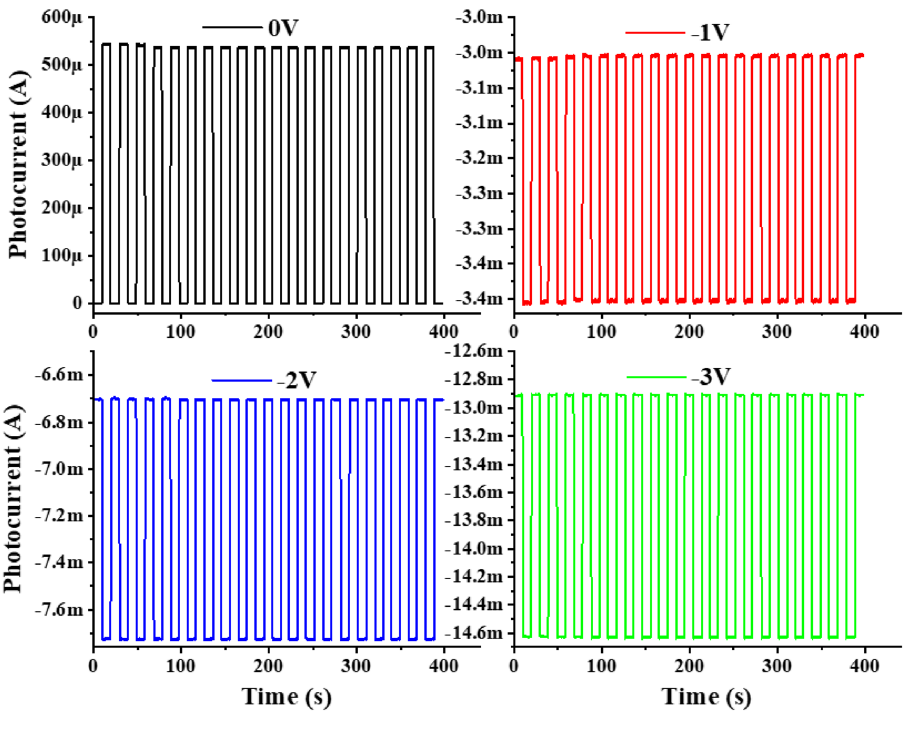
Figure 6. Bias dependent time-correlated transient photoresponse of GaN-NTs UV-PD at 3 mW optical power illumination.